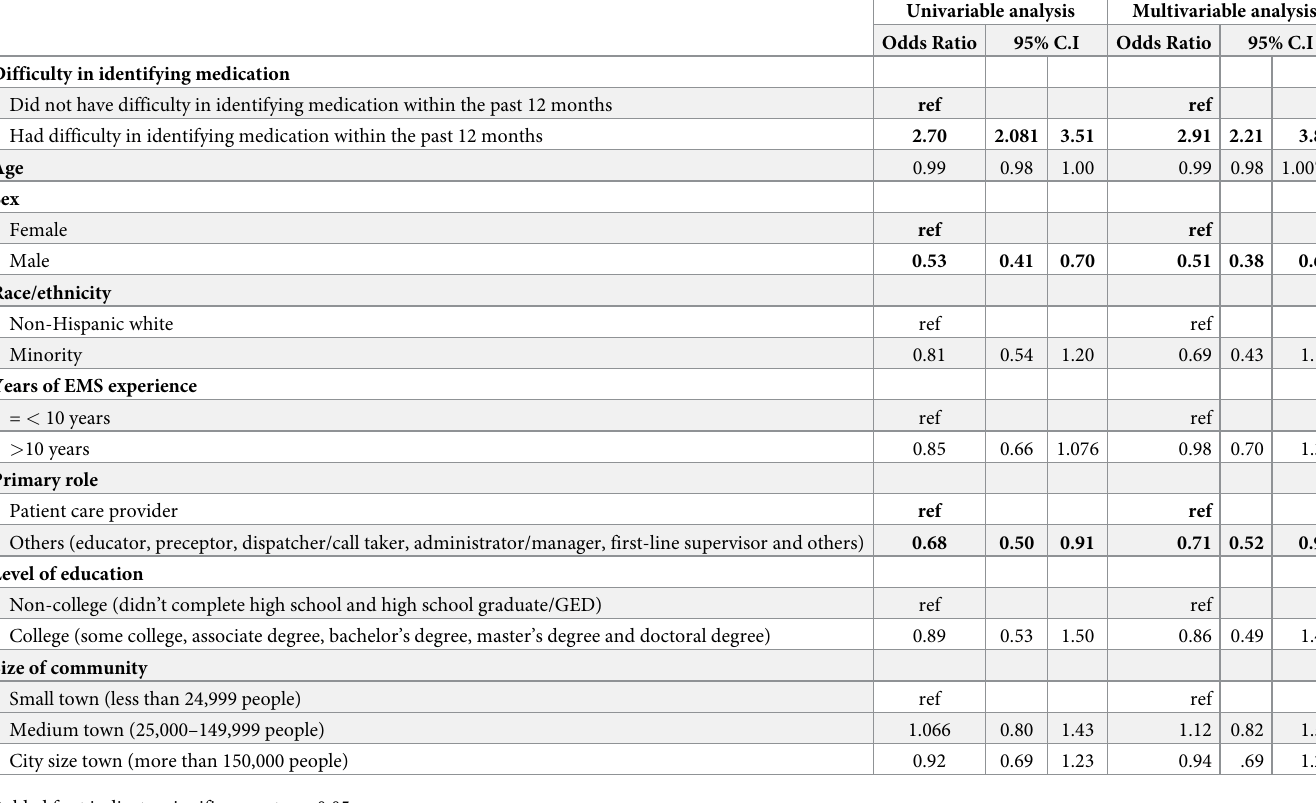
Bolded font indicates significance at α =